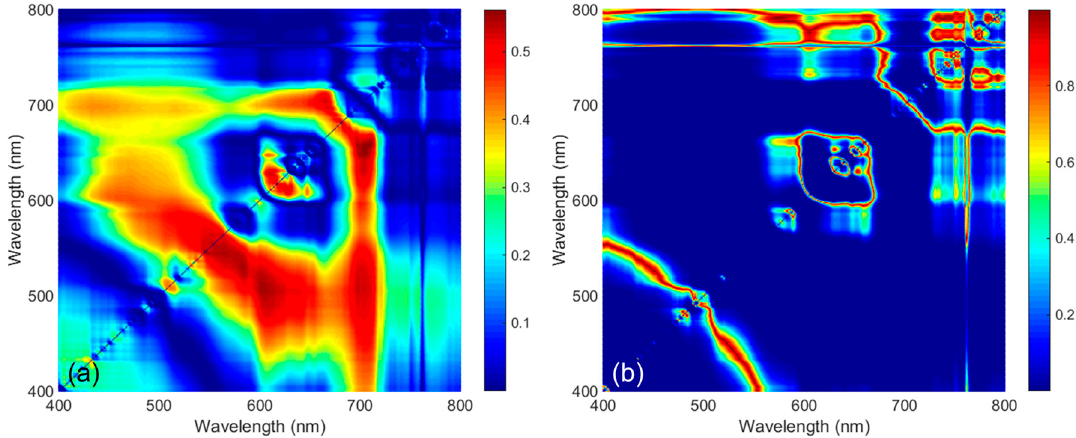
Figure 6. ( a ) R 2 values and ( b ) p -values of in situ R rs spectral ratio at each wavelength band. The x-axis and y-axis are in situ R rs by wavelength. R 2 values indicate the correlation between the ratio of x-axis to y-axis values and cell abundance.